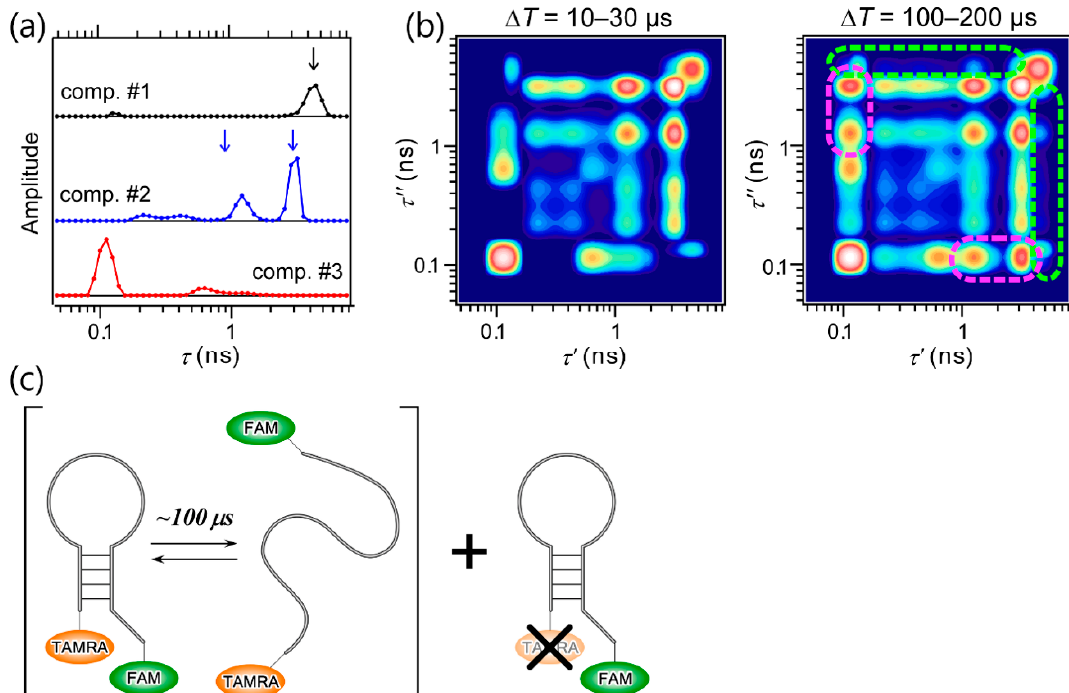
Figure 4. 2D FLCS of DNA hairpin. ( a ) Three independent lifetime distributions observed at Δ T = 10–30 µs, ( b ) 2D lifetime correlation maps at Δ T = 10–30 and 100–200 µs. Dashed lines indicate the regions where the cross peaks between components 1 and 2, 3 (green) and those between components 2 and 3 (magenta) are expected to appear. ( c ) Sketch of the folding dynamics of the DNA hairpin observed by 2D FLCS. Adapted with permission from Ref. [25], Copyright 2013, American Chemical Society.